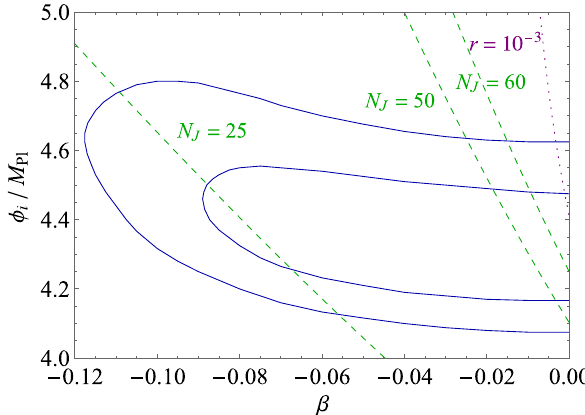
Fig. 3 Observational constraint from CMB by Planck and BICEP2/Keck Array [21] on parameter space (β,φ i / M Pl ) for the case β (cid:2) 0 ,γ = − 1. The 68% and 95% confidence regions ( blue ), the Jordan frame e-folds N J counted back from φ c ( green , dashed ), and r = 10 − 3 ( purple , dotted